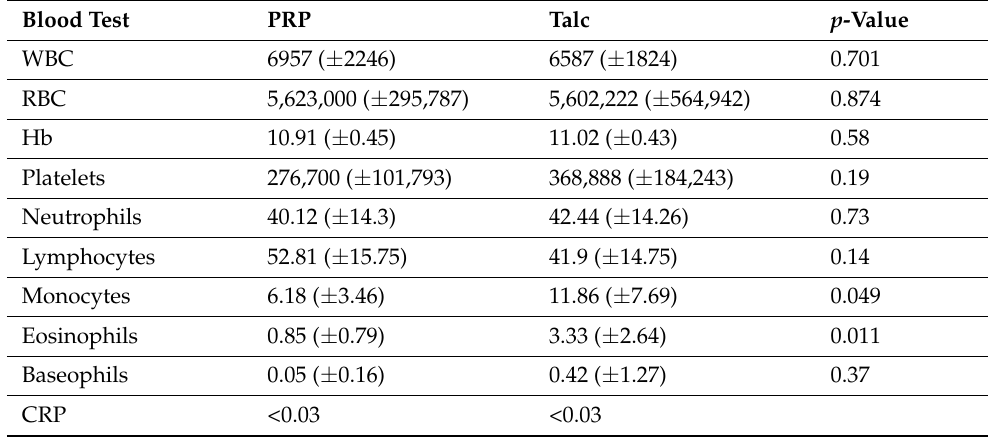
Table 1. Blood test results comparing PRP and talc post-intervention values (mean ± SD).